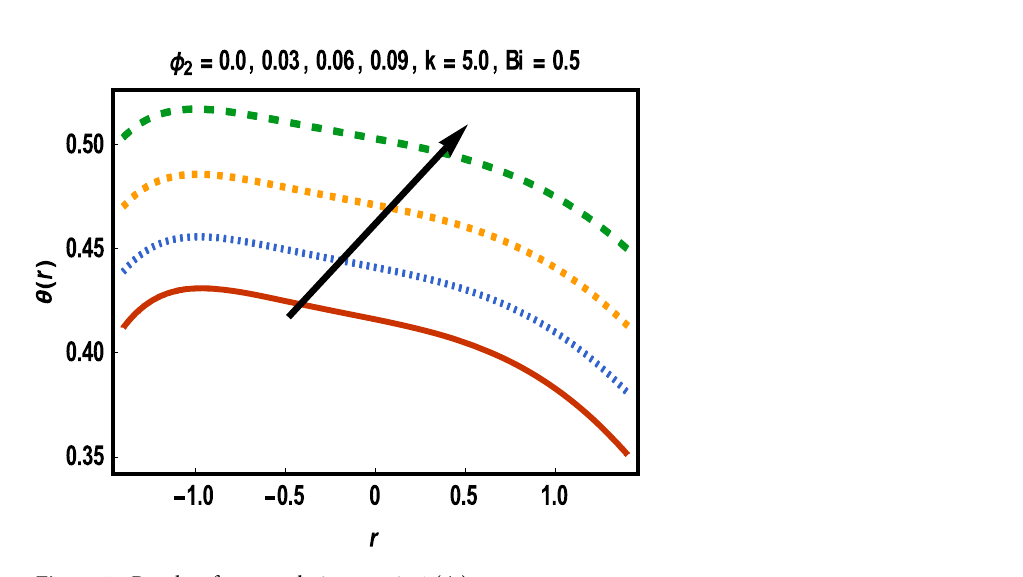
Figure 7. Results of case study 2: scenario 1 ( ϕ 1